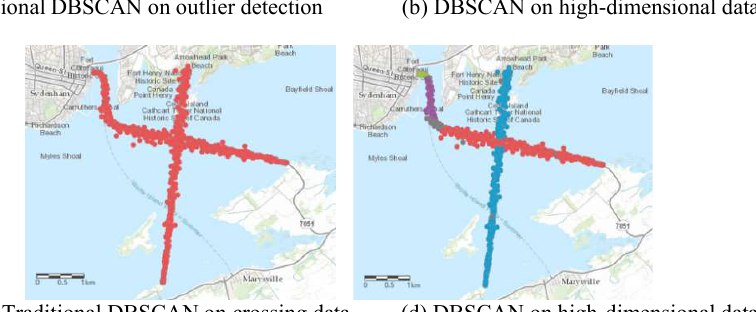
Figure Clustered Results - Number of Points